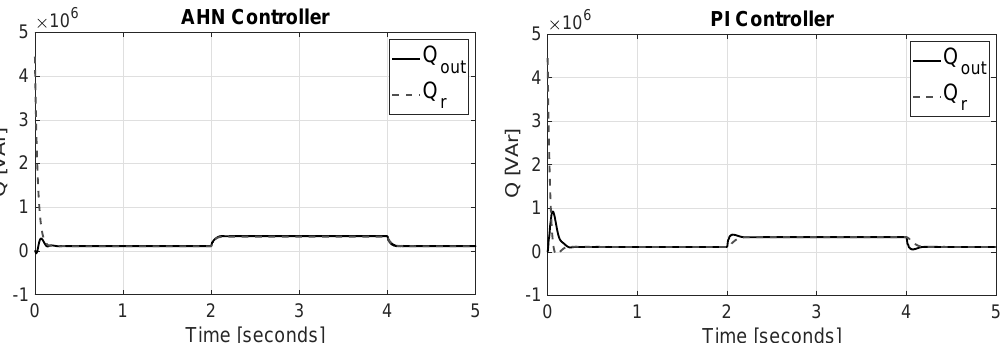
Figure 16. Simulation of reactive power regulation: Test 2.